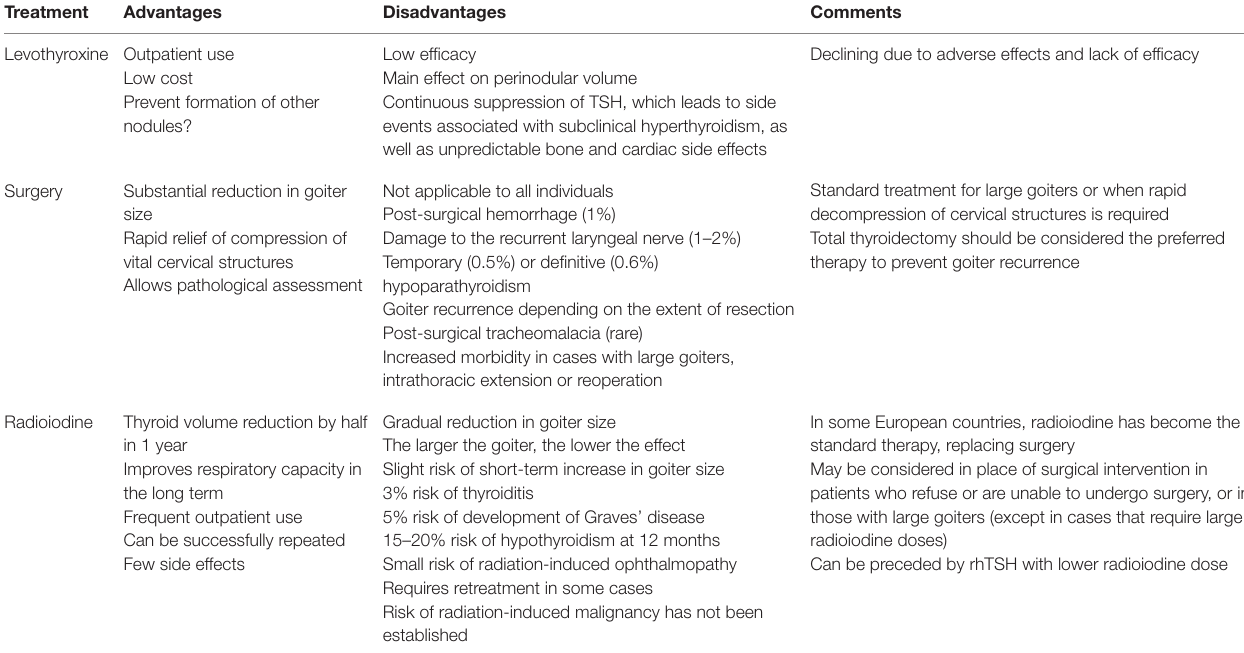
TABLe 2 | Therapeutic options for individuals with non-toxic multinodular